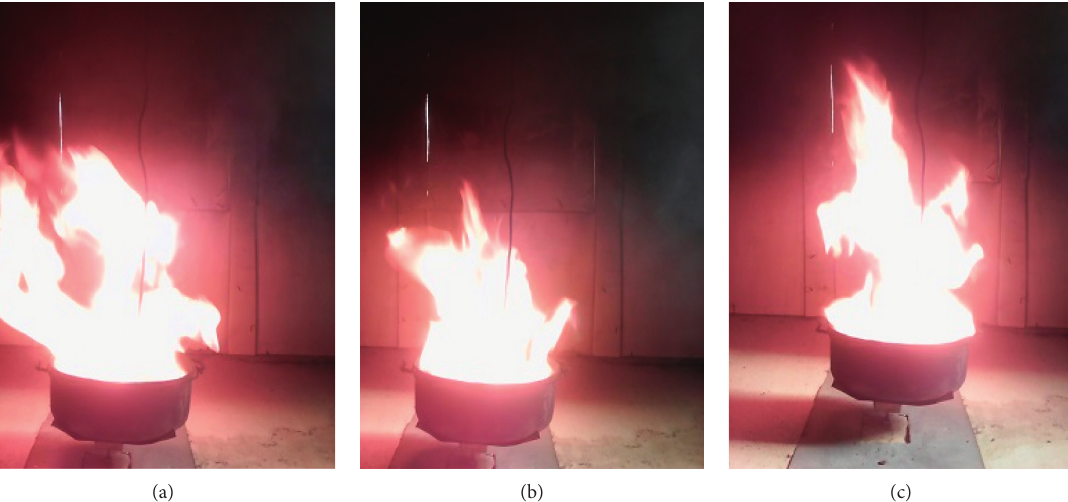
Figure 8: (a) Fire in the PFC configuration at time t time t 0